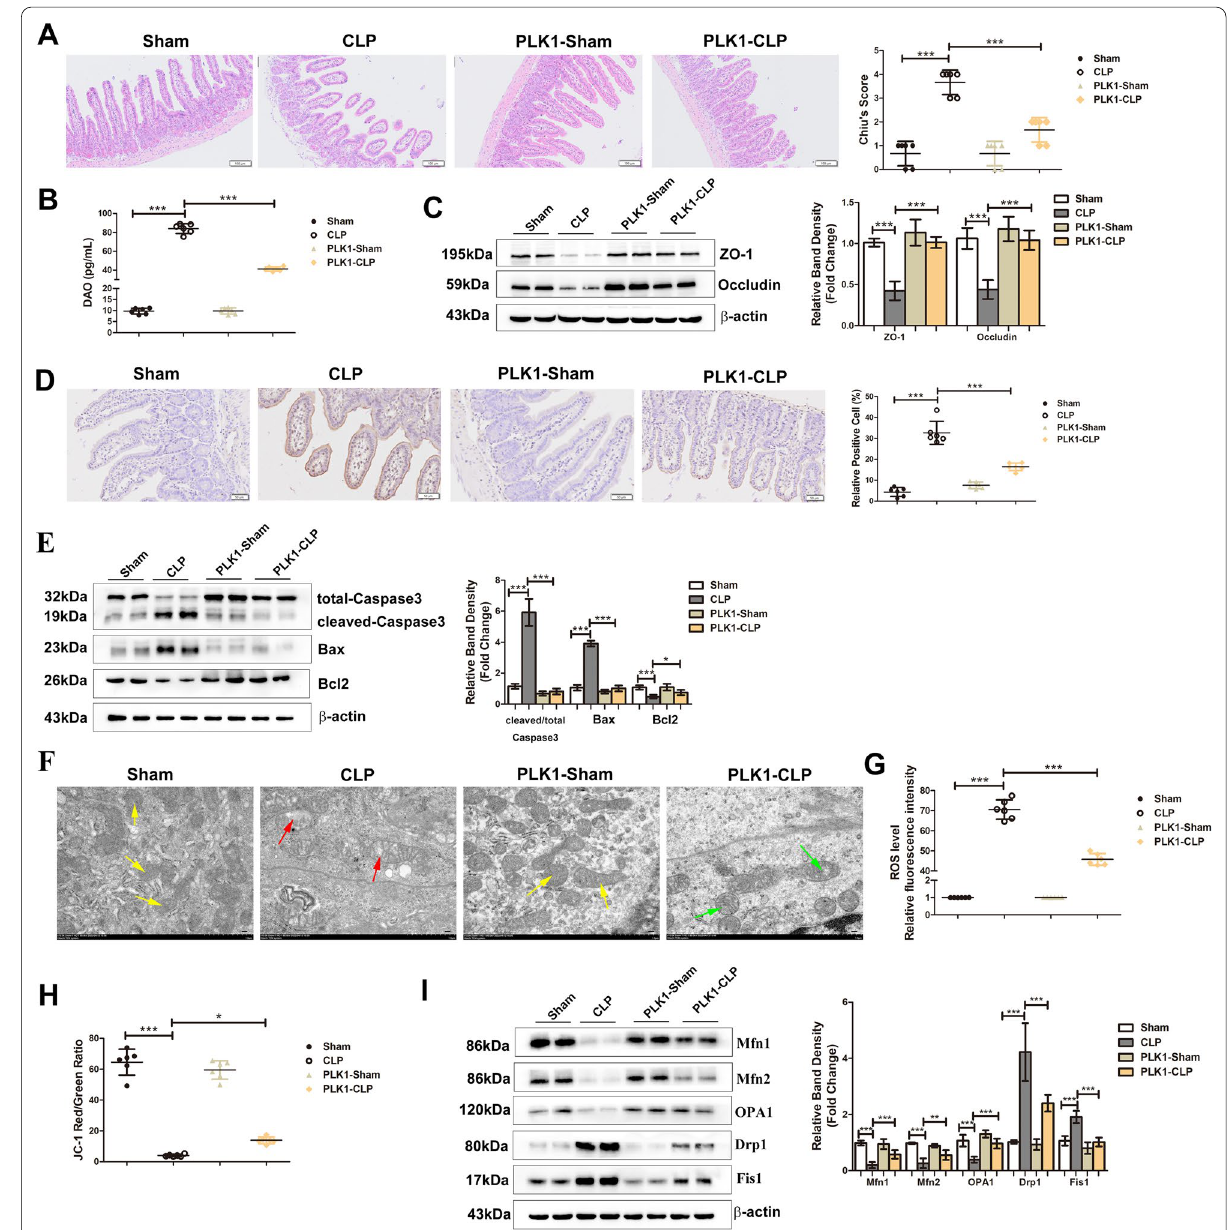
Fig. 2 PLK1 overexpression ameliorates sepsis‑induced intestinal injury. CAG‑PLK1 mice or wild type mice were underwent CLP and then analysed. A Microphotographs of H&E‑stained intestine sections from the indicated groups. The scale bar represents 100 μm. The Chiu’s score of each group shown right. B Serum concentrations of DAO in each group. C The levels of ZO‑1 and Occludin were analysed by Western blotting. The graph shows the relative band densities. D Representative images of TUNEL staining after the indicated treatments. The graph shows the percentage of TUNEL‑positive cells. The scale bar represents 50 μm. E The levels of apoptotic markers were measured by Western blots. The graph shows the relative band densities. F Morphological alterations in mitochondria were examined by TEM (scale bar 1.0 μm). Yellow arrows indicate the = relatively normal mitochondrial shape in the sham group. Red arrows denote deformed mitochondria with the loss of clearly defined cristae. Green arrows indicate rescued mitochondrial shape. G The relative fluorescence intensity of ROS in the intestine. H The ratio of JC‑1 red/green fluorescence intensity which reflecting the MMP level was shown in graph. I Representative Western blots showing mitochondrial fusion (Mfn1, Mfn2, OPA1) and fission (Drp1 and Fis1) on the left, and the right graph show the relative band densities. The data in the graphs are expressed as the mean SD. * P < 0.05, ** P < 0.01, *** P < 0.001 (n ± =